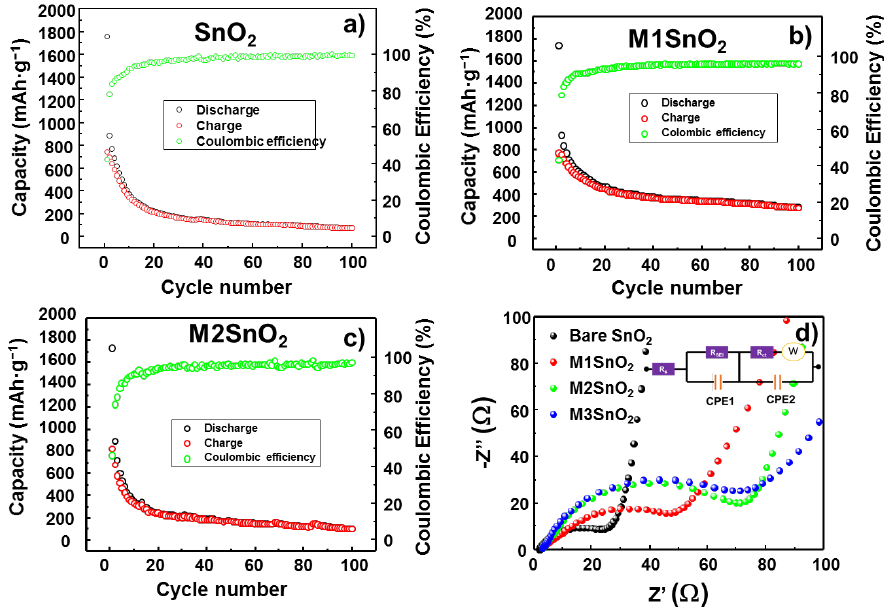
Figure 7. Cyclic performances and Nyquist plots of ( a ) SnO 2 NPs and ( b – d ) M1 / M2 / M3SnO 2 anodes. Table 1. Resistance values extracted from the equivalent circuit of M1 / M2 / M3SnO 2 anodes.